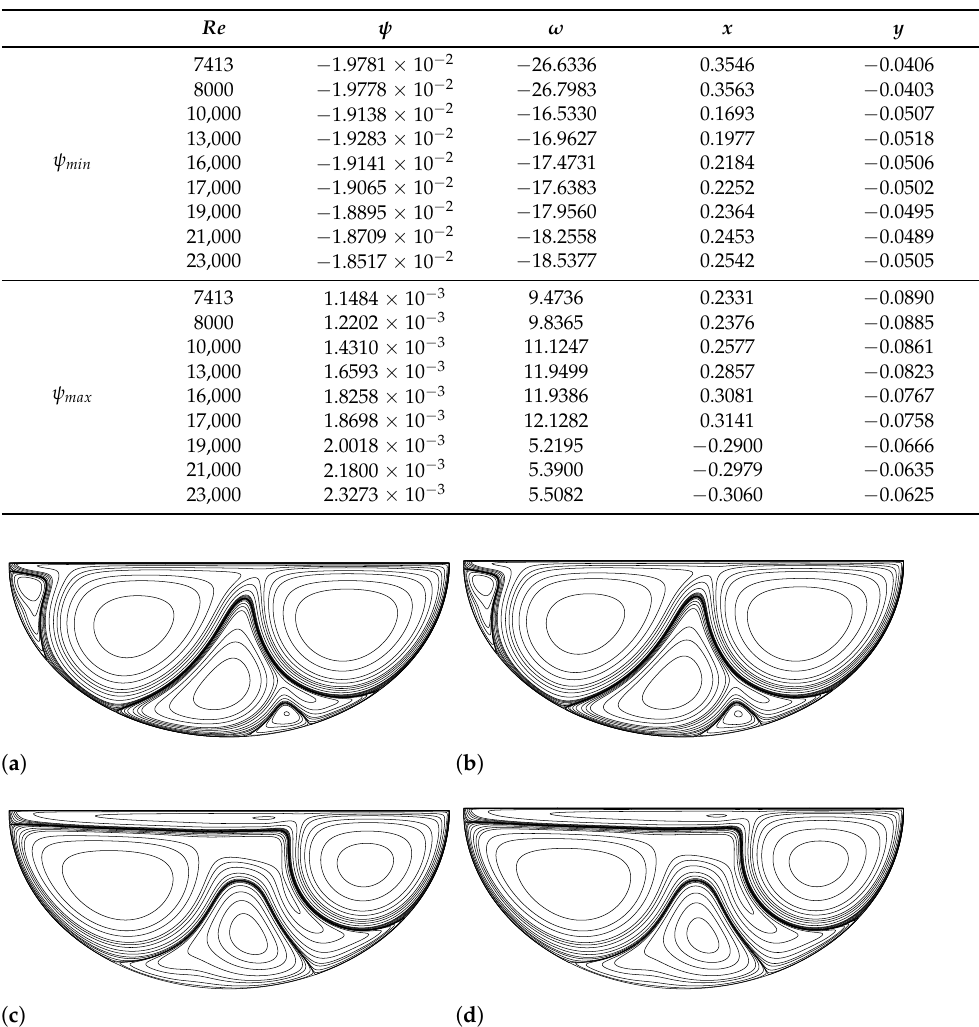
Figure 12. The solution of semi-elliptical cavity flow at Re = 12,000 with various aspect ratios. ( a ) D = 0.79. ( b ) D = 0.80. ( c ) D = 0.81. ( d ) D =